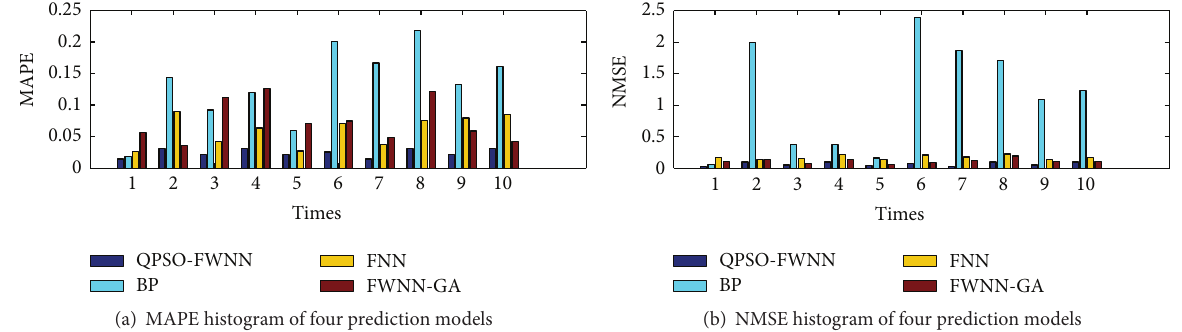
Figure 11: MAPE and NMSE histogram of four prediction models.